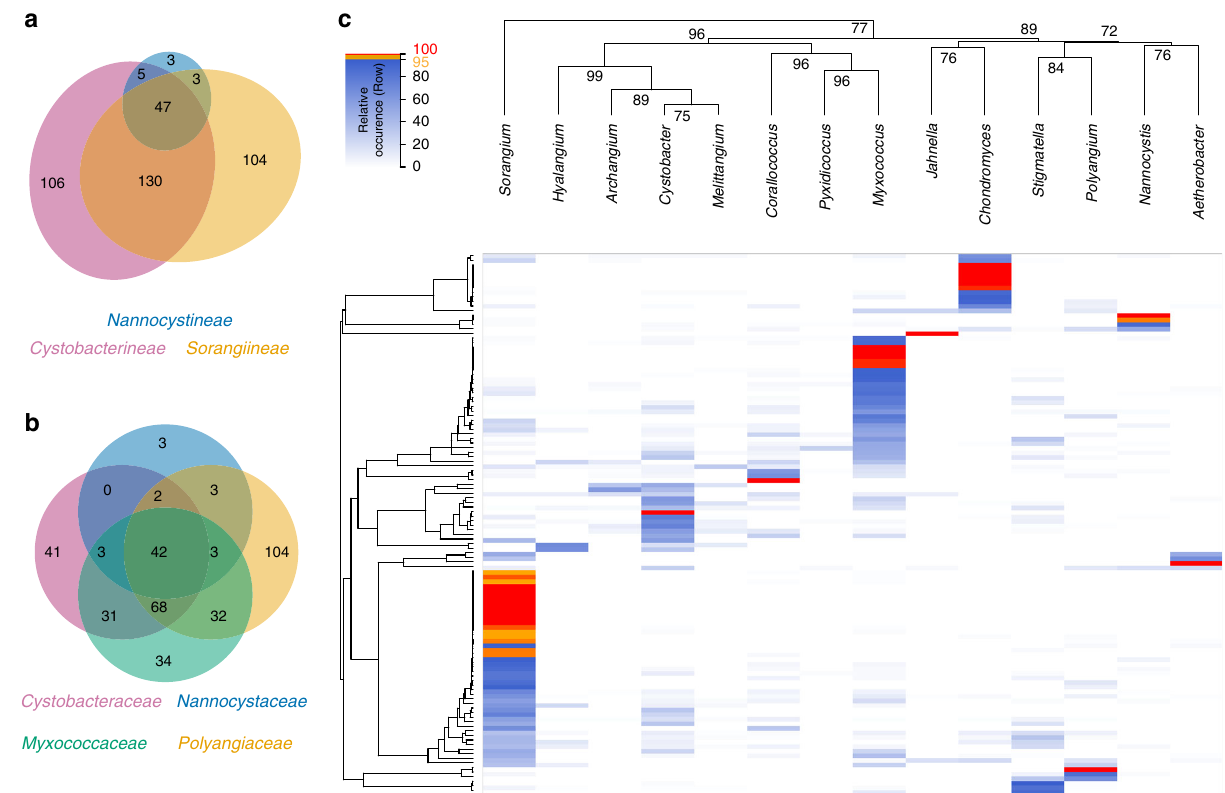
Fig. 2 Distribution of known myxobacterial compounds amongst extracts from ~2300 strains. a Venn diagram on suborder level. b Euler plot on family level (overlap numbers between opposite circles not printed). c Heatmap displaying known compound families found among the myxobacterial genera after UPGMA-based hierarchical clustering. Red color indicates 100% of detections within one genus, i.e., the compound family is solely found in this genus although not necessarily in all data sets of the respective genus. Compound families that were more than 95% occuring within one genus are orange. The data sets originate from genera comprising at least 5 corresponding strains: Aetherobacter (5 strains), Archangium (26), Chondromyces (50), Corallococcus (249), Cystobacter (242), Hyalangium (22), Jahnella (8), Melittangium (44), Myxococcus (799), Nannocystis (146), Polyangium (112), Pyxidicoccus (23), Sorangium (499), and Stigmatella (77). A total of 170 metabolite families were considered, covering 398 compounds. Column clustering was subjected to bootstrapping ( n = 500) with ‘ approximately unbiased ’ p -values